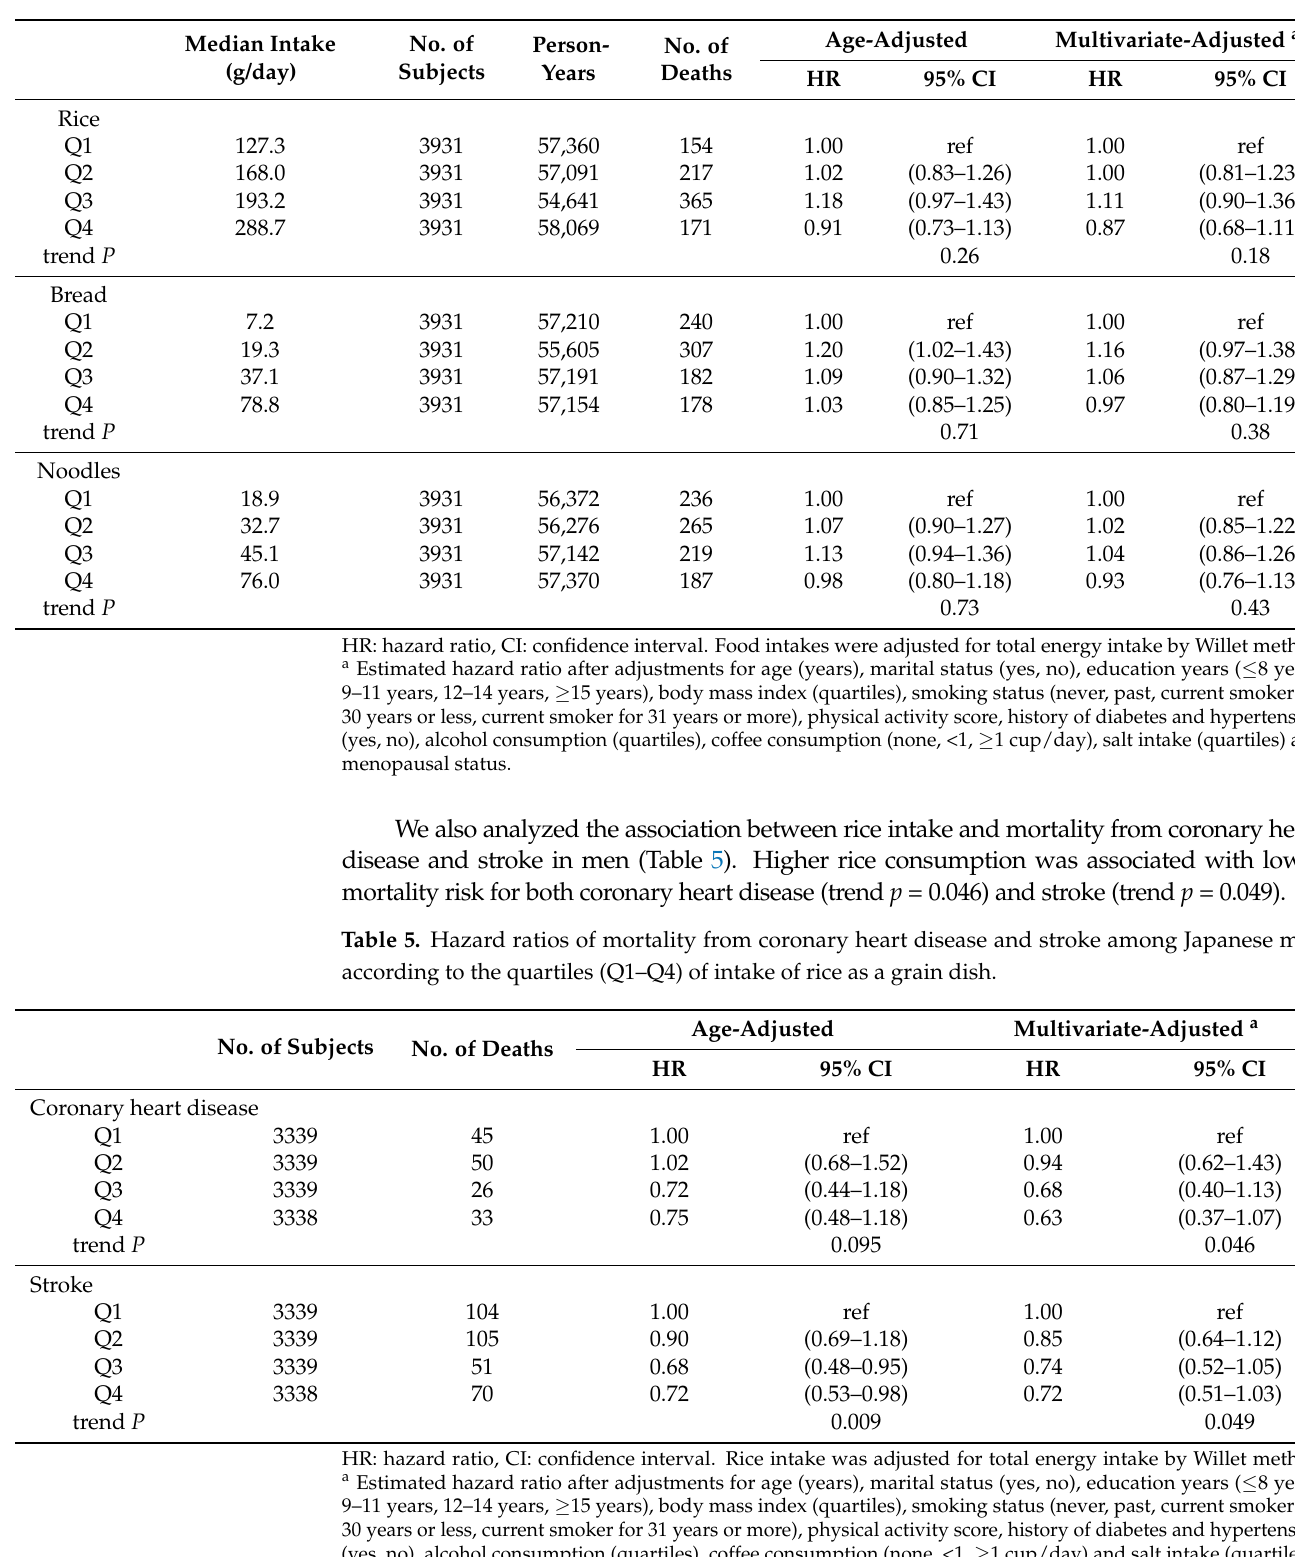
Table 4. Hazard ratios of cardiovascular disease mortality among Japanese women according to the quartiles (Q1–Q4) of intakes of rice, breads, and noodles as grain dishes.